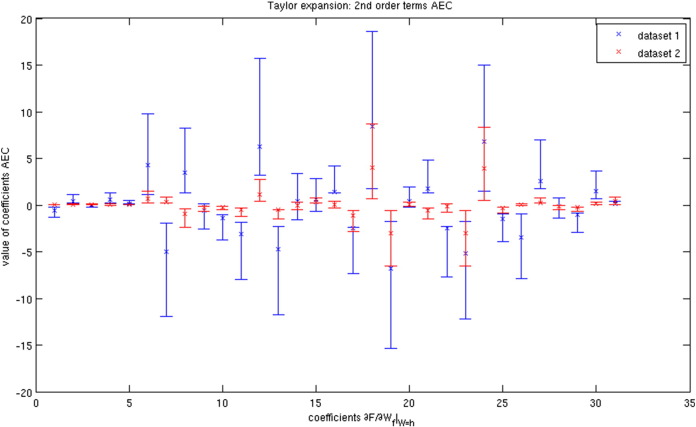
Estimated parameters (Taylor coefficients) for analysis level 1 using model d, linear + non-linear approximation based on all MEG frequency bands using the PLI as functional connectivity metric for MEG. Note that the confidence intervals of the estimated Taylor coefficients for the two datasets sometimes overlap, but also show discrepancy between the two datasets.